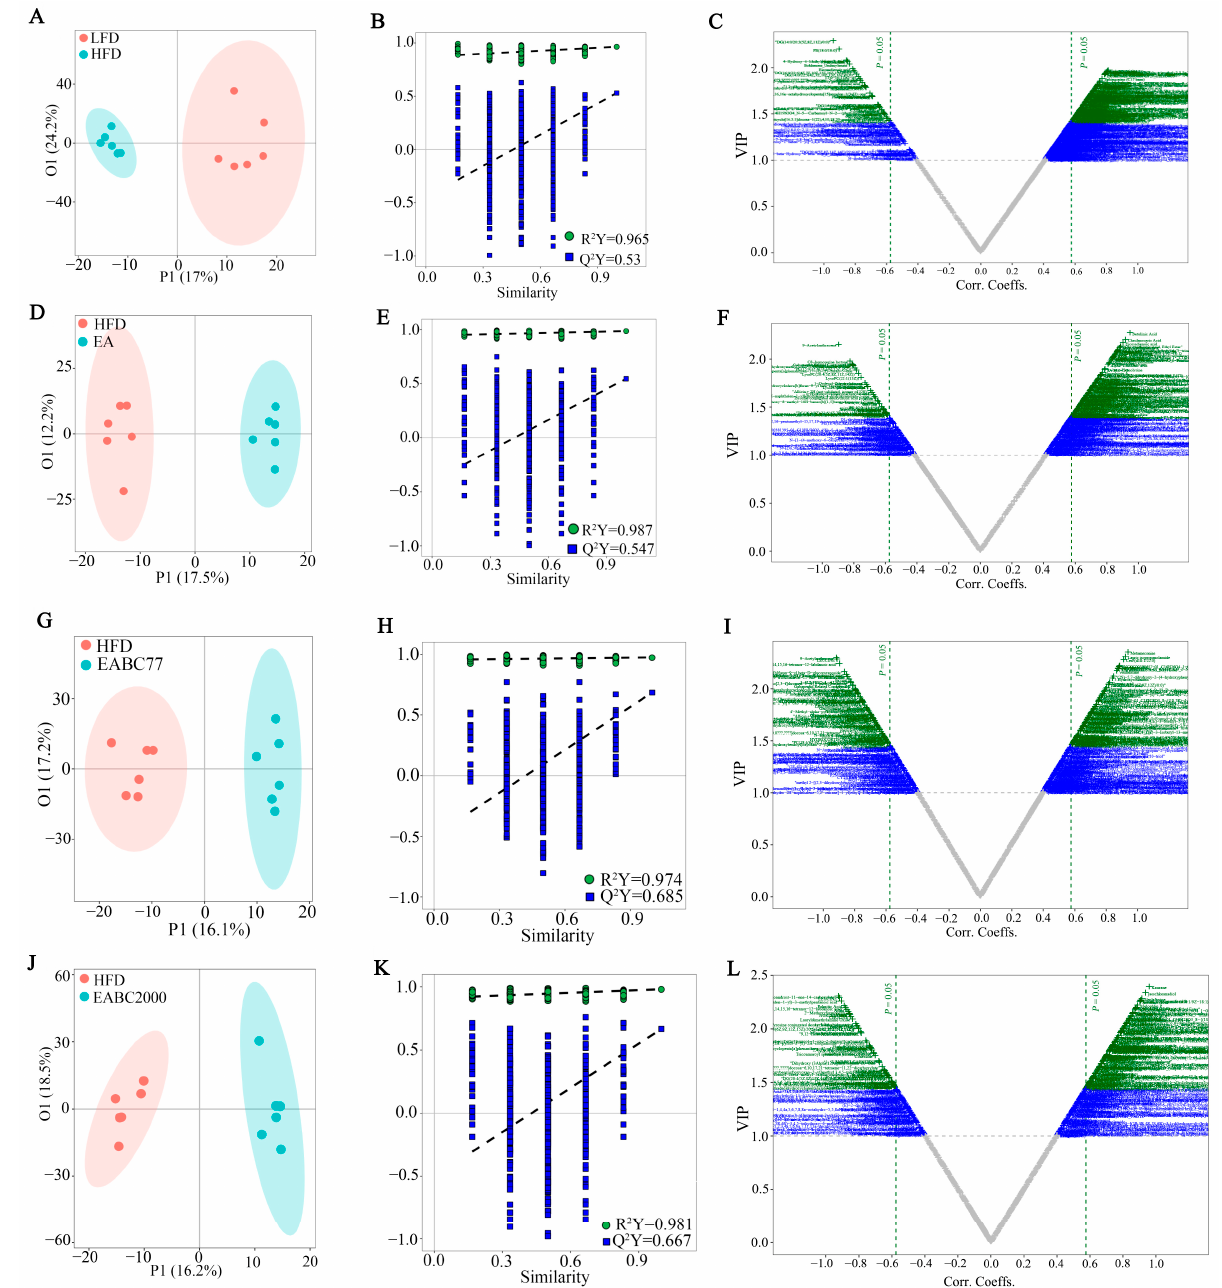
Figure 4. Untargeted metabolomic analysis of mouse plasma metabolites by UPLC-QTOF MS/MS. OPLS-DA score plot ( A : R2Y = 0.965, Q2Y = 0.53; D : R2Y = 0.987, Q2Y = 0.547; G : R2Y = 0.974, Q2Y = 0.685; J : R2Y = 0.981, Q2Y = 0.667), the corresponding permutation plots ( B , E , H , K ), and v-plot ( C , F , I , L ). LFD: low-fat-diet group; HFD: high-fat-diet group; EA: ellagic acid intervention group; EABC77: EA + Weizmannia coagulans BC77 intervention group; EABC2000: EA + Weizmannia coagu- lans BC2000 intervention group. Table 2. Differential metabolites in the mouse plasma.